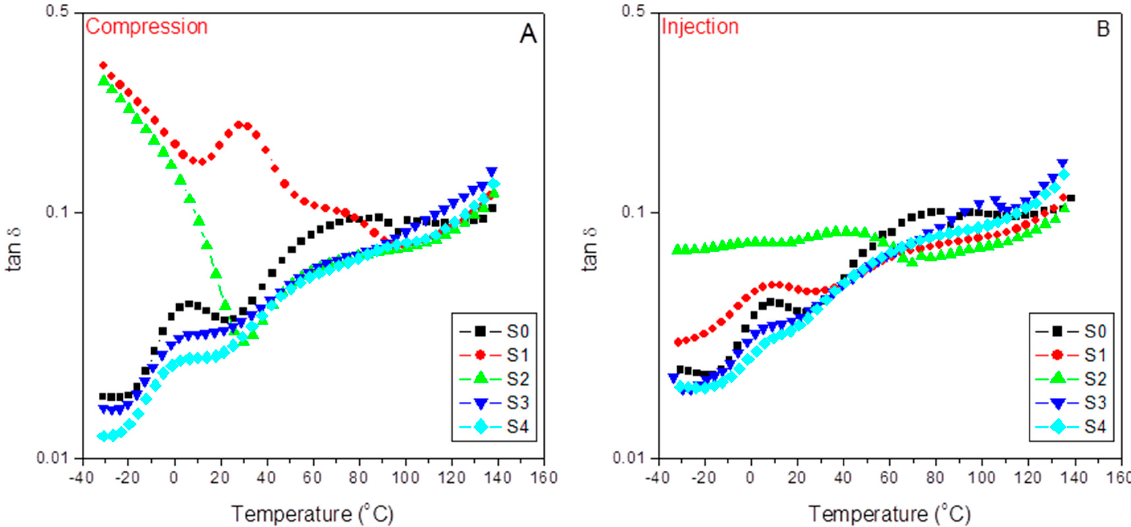
Figure 10. Evolution of the damp factor (tan δ ) with temperature for the indicated samples: ( A ) compression-molded; ( B ) injection-molded. Table 7. Transition temperatures for the indicated samples.